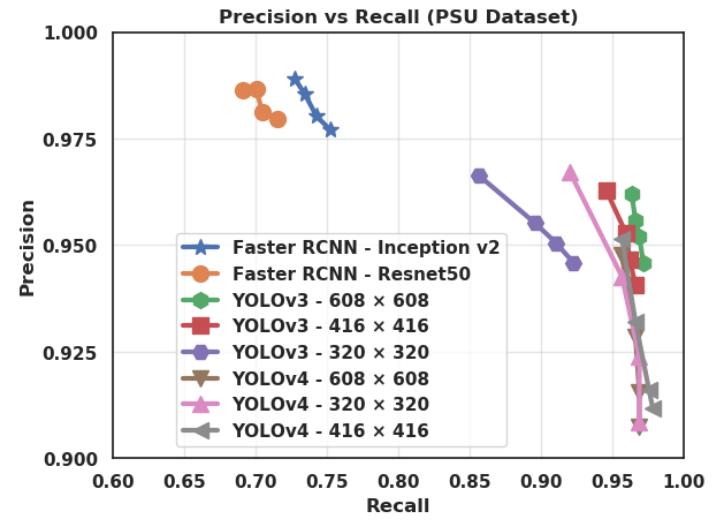
Figure 9. Precision vs. Recall for different values of score threshold (0.3, 0.5, 0.7, and 0.9), and IoU = 0.6 (Intersection over Union), on the PSU (Prince Sultan University) dataset.